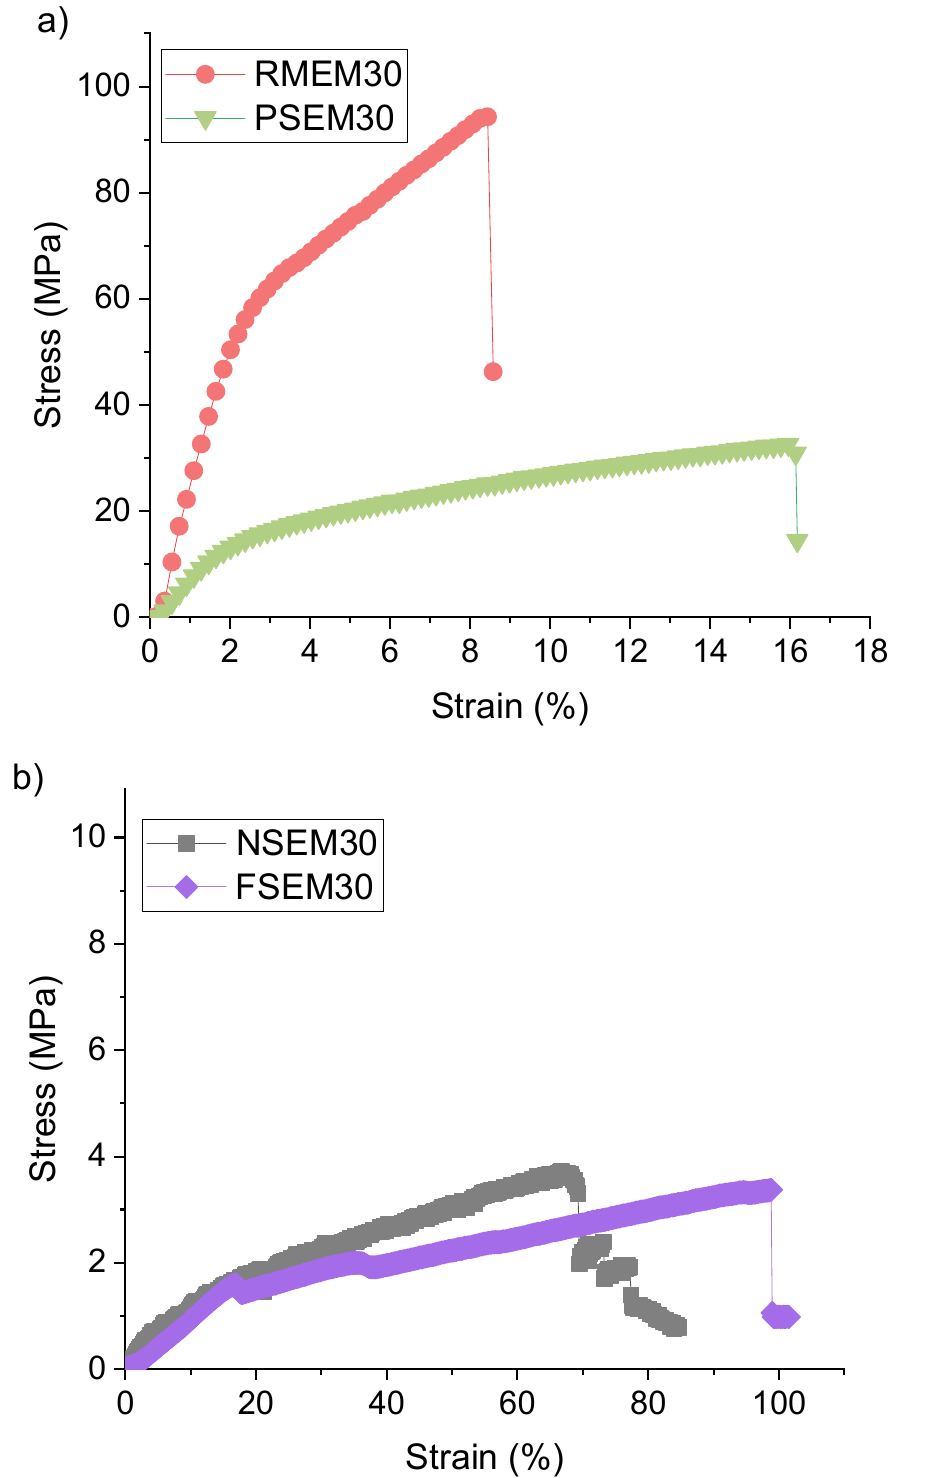
Figure 6. Stress–strain curves of the unsupported and supported electrospun nanofibrous membranes for 30 min electrospinning time. ( a ) RMEM and PSEM using the RO membrane and permeate spacer, respectively, with 30 min electrospinning time; ( b ) NSEM and FSEM using unsupported and feed spacer, respectively, with 30 min electrospinning time.